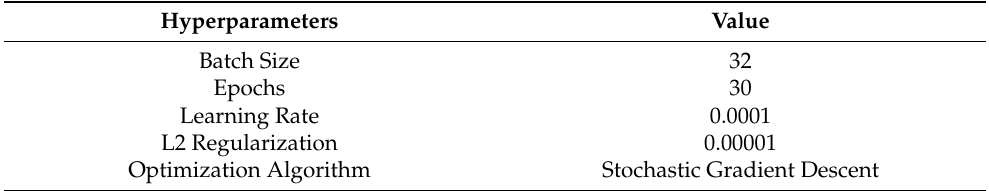
Table 7. Hyperparameters used for